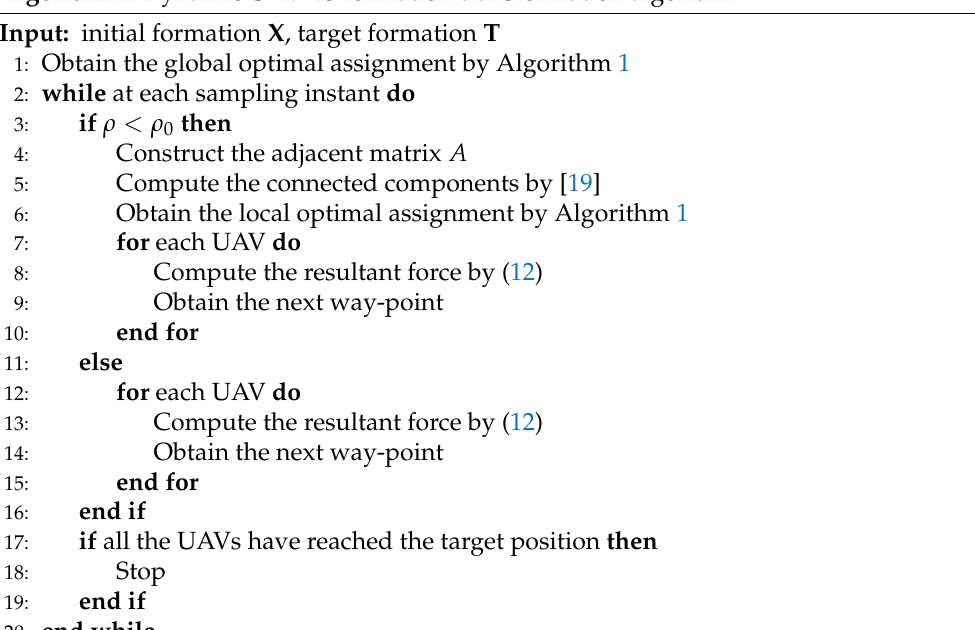
Algorithm 2 Dynamic UAV-LS formation transformation algorithm